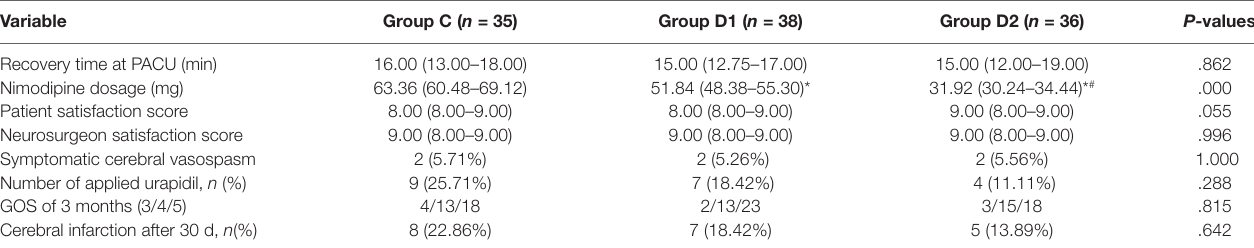
TABLE 4 | Consumption of postoperative variables in the three groups.